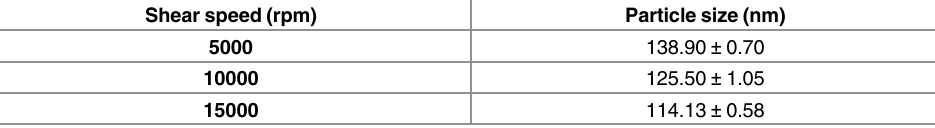
Table 3. Particle size (nm) of nanoemulsion at different shear speed (rpm).